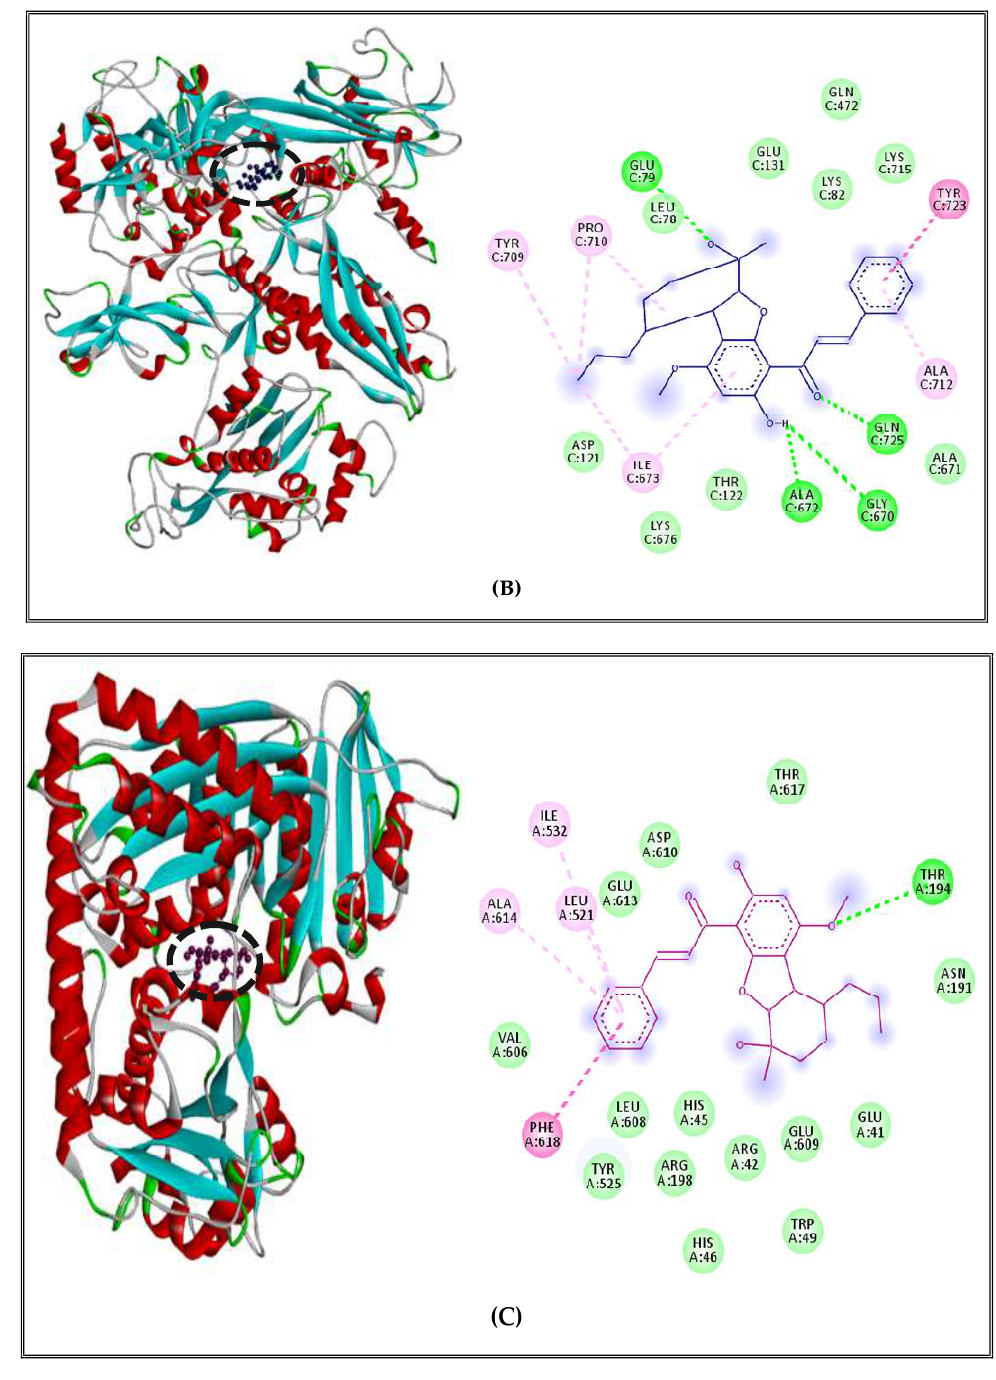
Figure 8. Borneol complexed with DNA polymerase enzyme ( A ), RNA polymerase ( B ), topoiso- merase II ( C ) of S.aureus.